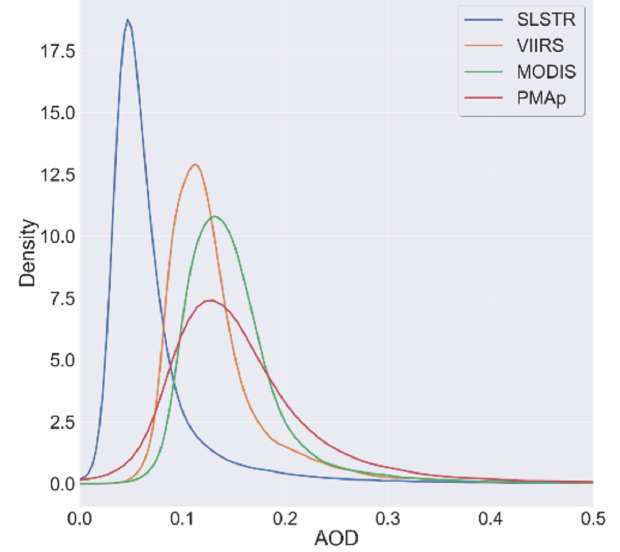
Table 2. Quantification of global AOD differences between satel- lites and instruments for the DJF period over